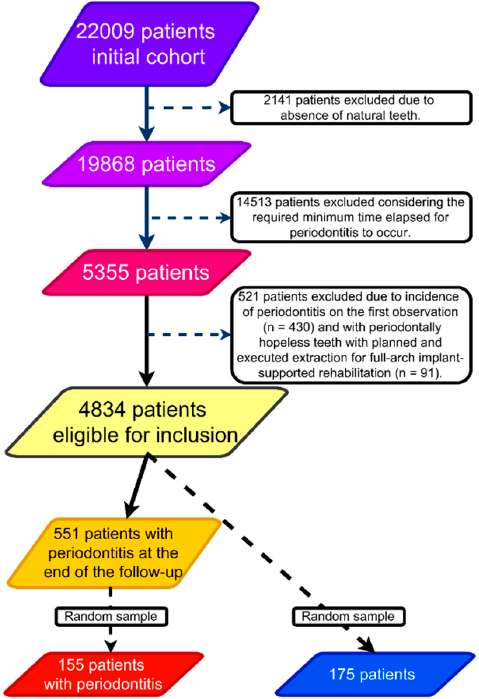
Figure 1. Flowchart illustrative of the case-cohort study design and sampling methods performed in the present study.